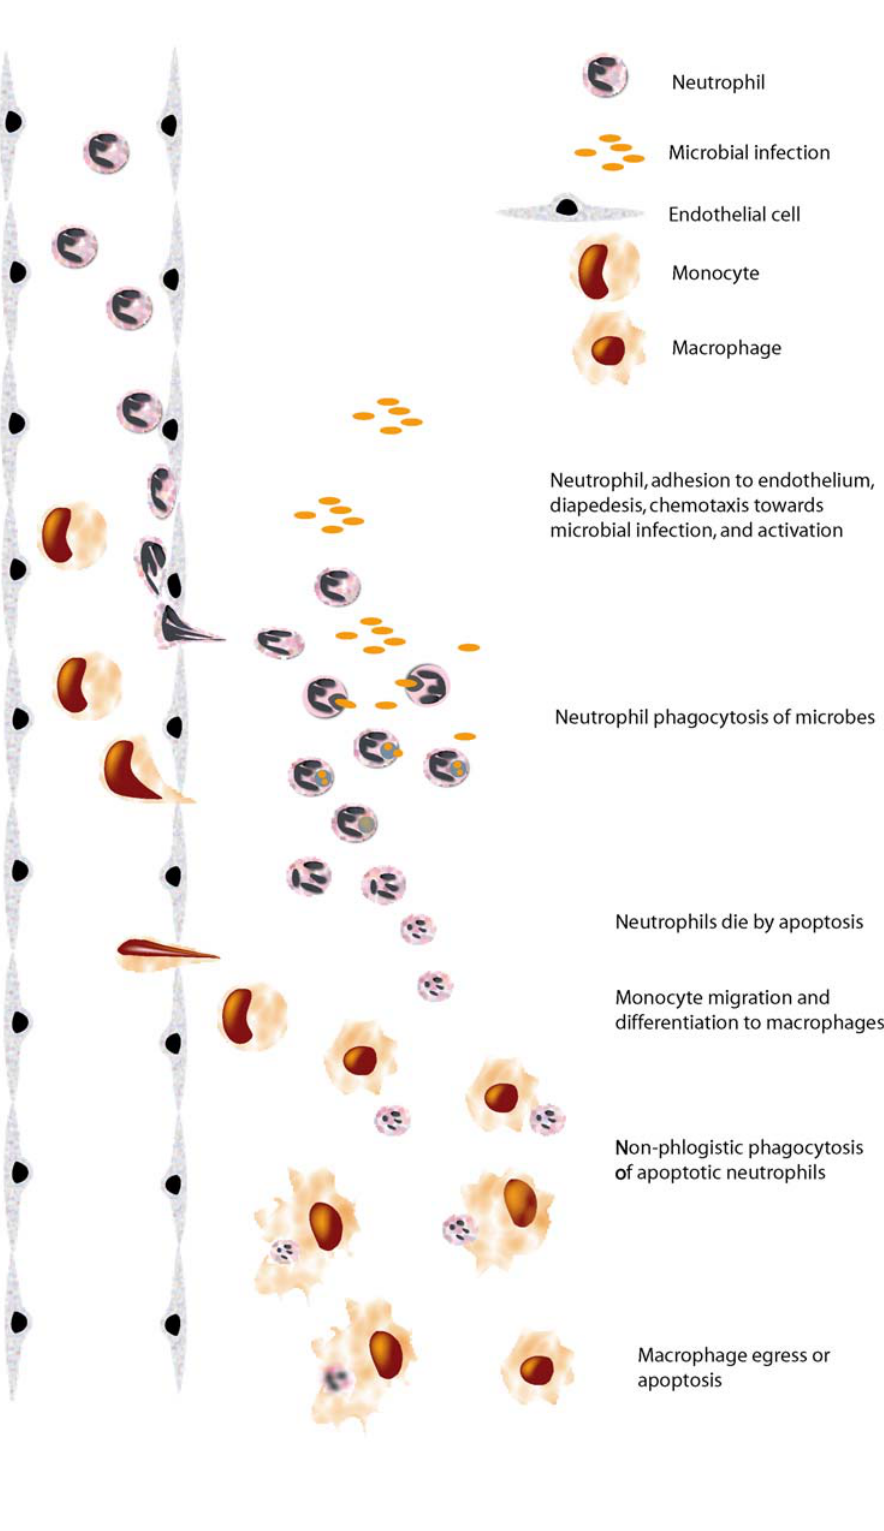
FIGURE 1 . Representation of the temporal cellular events in the evolution of